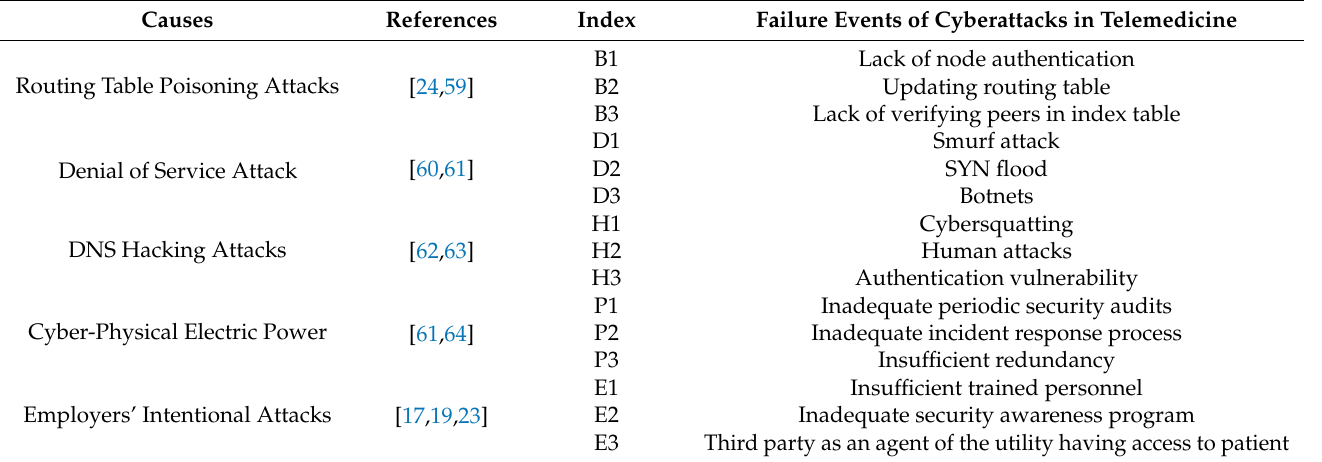
Table 2. Failure events of cyberattacks in